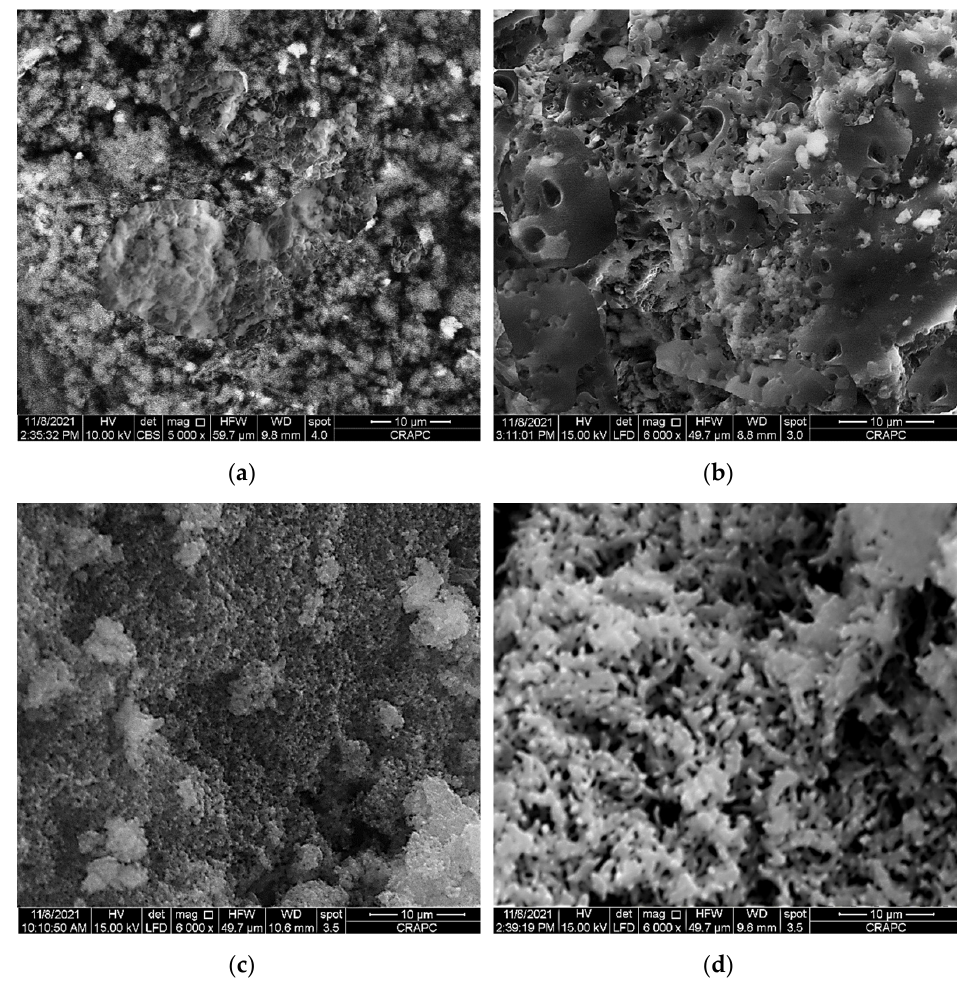
Figure 4. Scanning electron microscope (SEM) micrographs of: ( a ) raw PPS, ( b ) PPSH, ( c ) PPSOH and ( d ) PANI@PPSH.